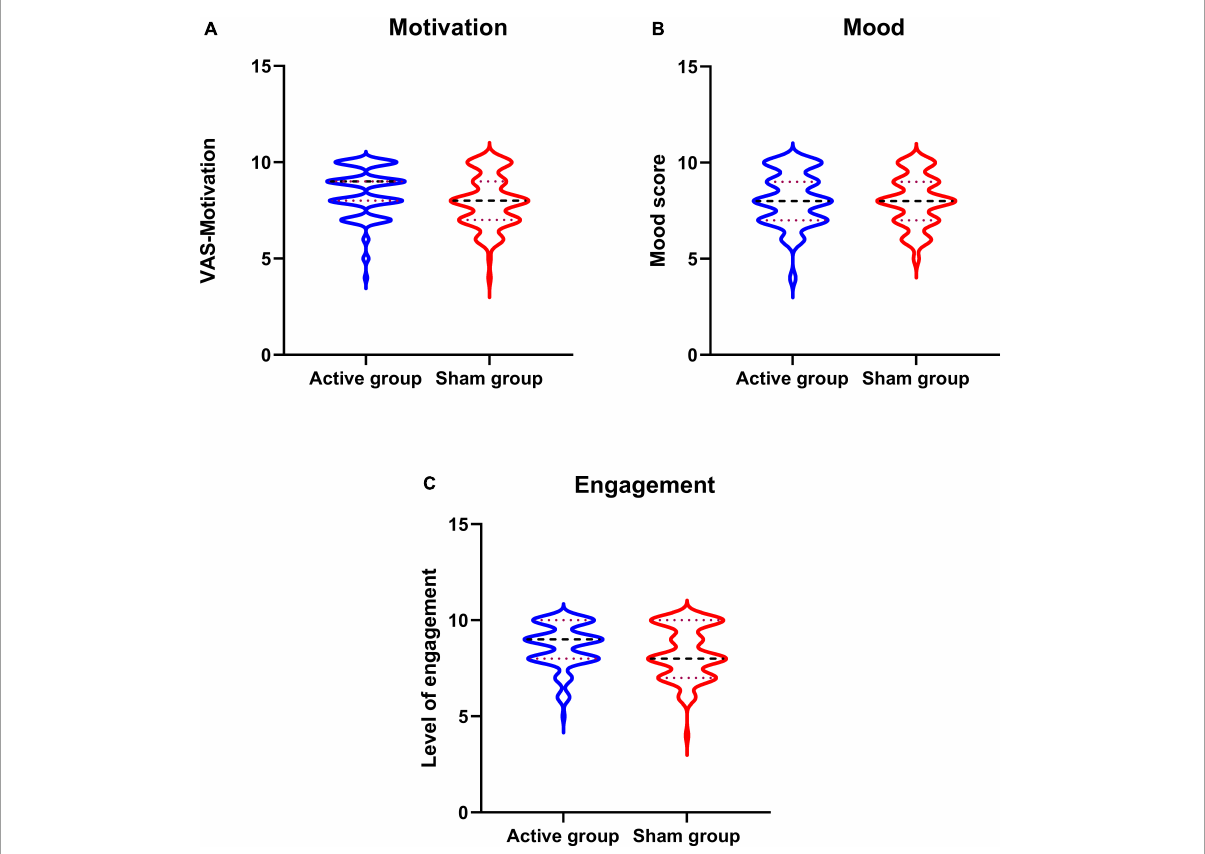
FIGURE3 Overall motivation, mood, and engagement with neurofeedback training sessions. (A–C) Violine plot of participants motivation and mood recorded before every neurofeedback session and level engagement scores recorded after the